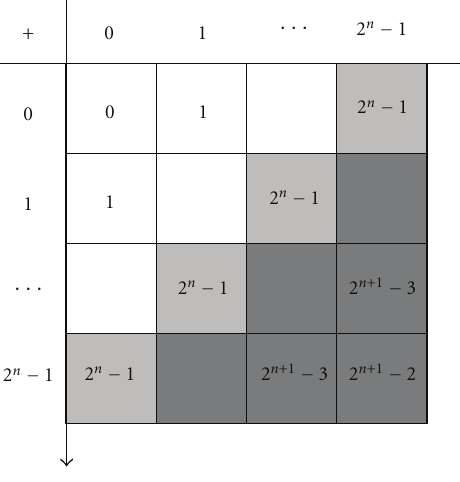
Figure 1: Carry generation in the